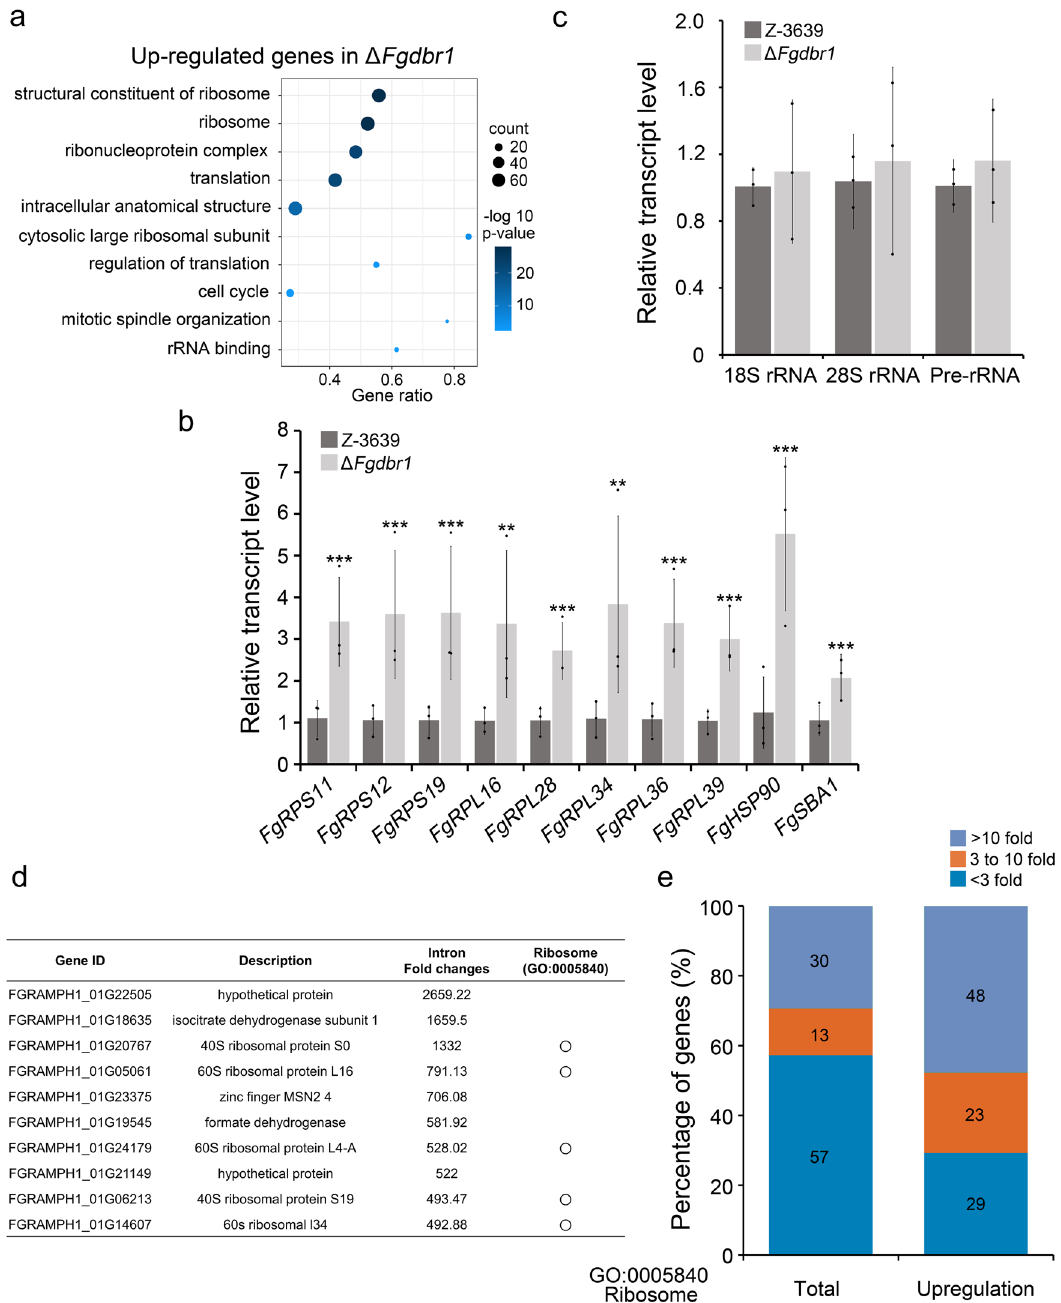
Fig. 5 Transcript and intronic expression signatures in Δ Fgdbr1 mutant. a Gene ontology (GO) enrichment analysis of the upregulated genes in the Δ Fgdbr1 mutant. b Transcript levels of ten selected genes related to ribosome and translation in the F. graminearum strains. Transcript levels of selected genes were quanti fi ed by qRT-PCR. c Relative amount of ribosomal RNAs (rRNAs) in the wild-type and Δ Fgdbr1 strains. 18 S, 28 S and pre- rRNA levels were quanti fi ed by qRT-PCR. Error bars represent standard deviations of three biological replicates. ** p < 0.01; *** p < 0.001. d List of genes containing top 10 enriched intron lariat in Δ Fgdbr1 mutant compared to wild type. e The proportion of genes with the intron lariat fold changes in three categories. Relative intron lariat levels of total genes or upregulated genes corresponding GO term ‘ ribosome (GO:0005840) were analyzed based on RNA-set data of each